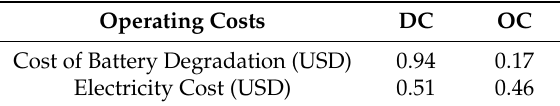
Table 2. Operating cost comparison of one time charging.